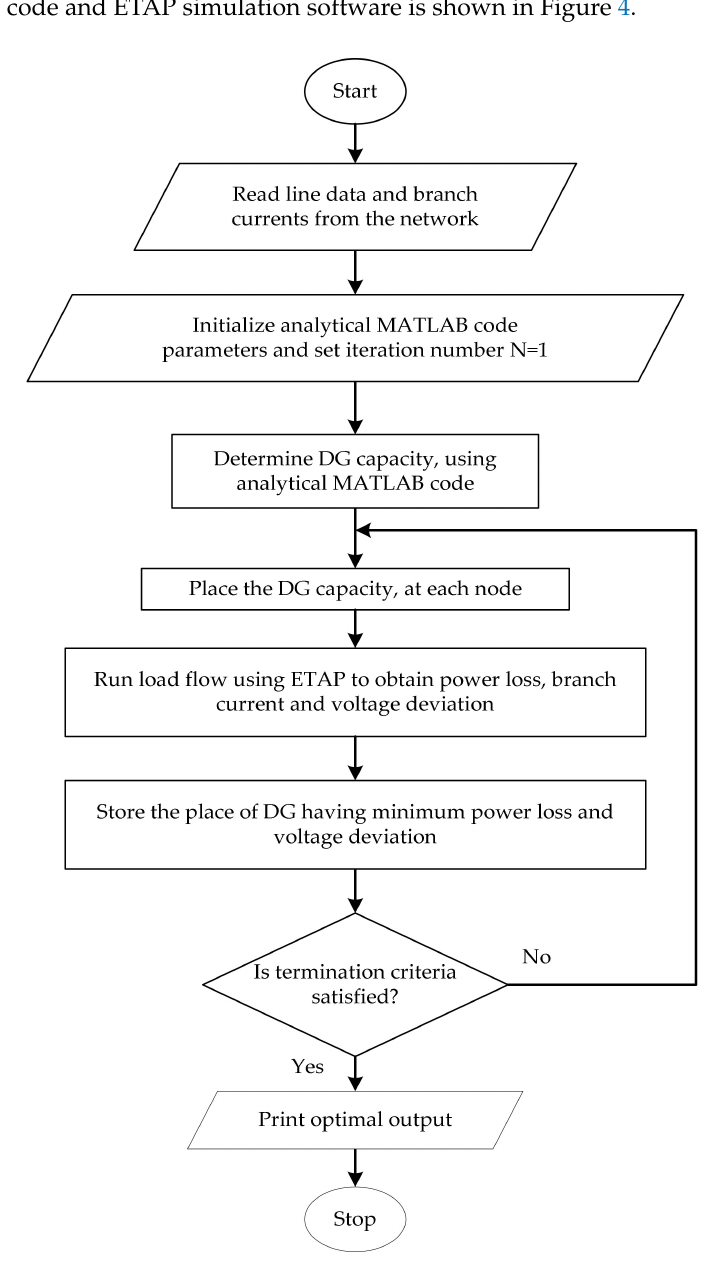
Figure 4. The optimal DG sizing and location